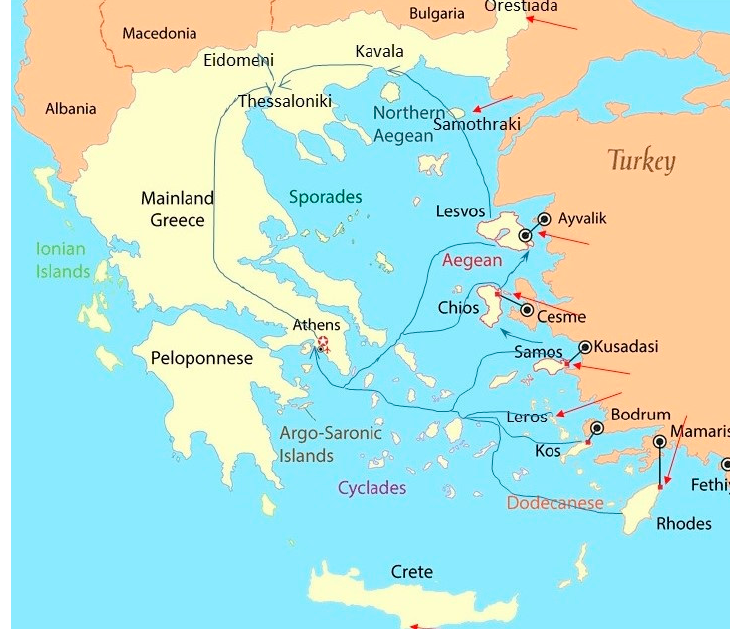
Figure 1. Migrant routes, modified from Source: United Nations High Commissioner for Refugees (UNHCR 2017).